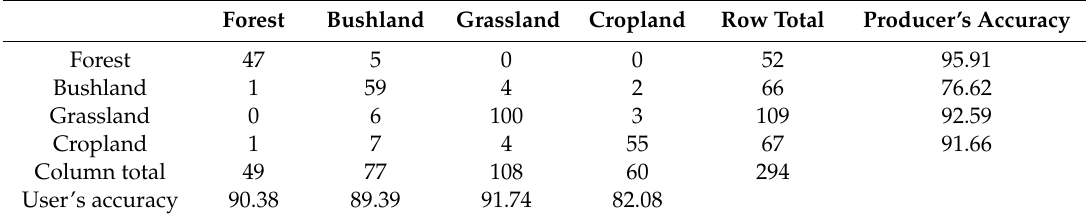
Table A2. Errors of omission and commission per class in the land cover